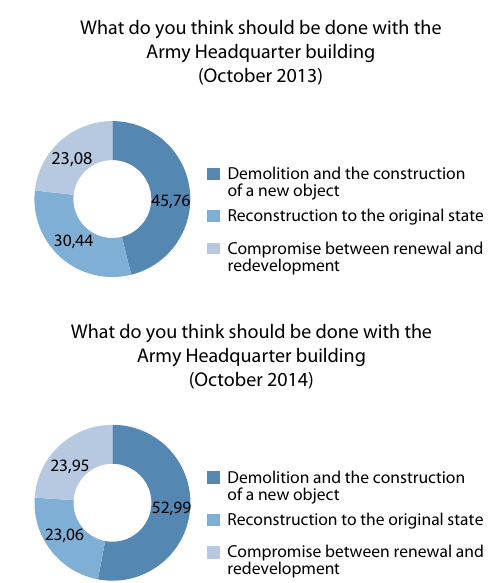
fig. 5. results of the online public opinion poll in two cross- sections. Source : BEoBuIlD